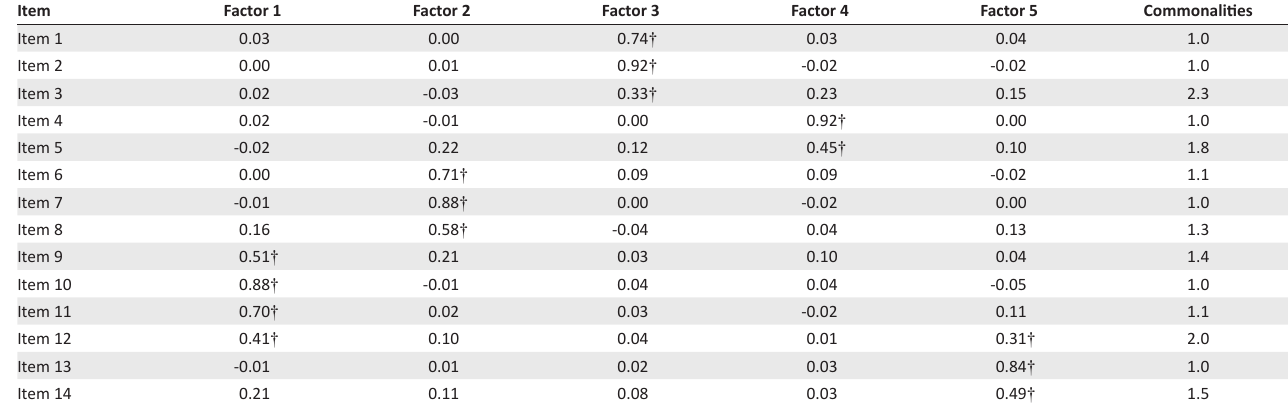
TABLE 2: Exploratory factor analysis.